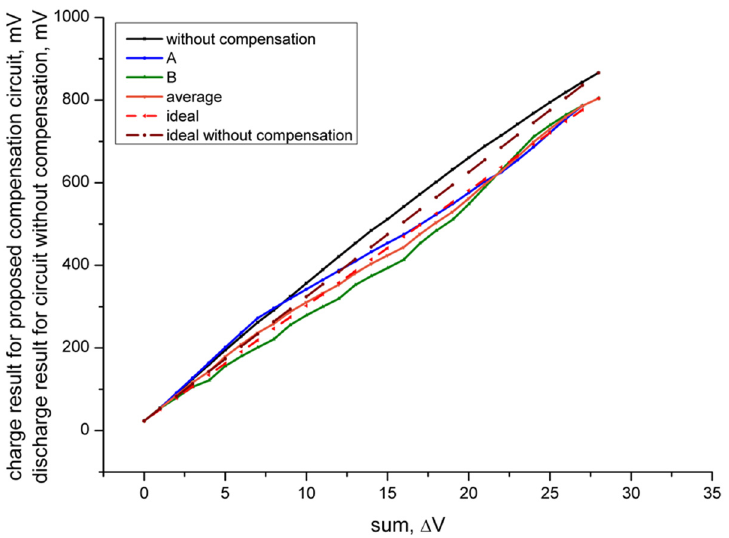
Figure 4. Accumulation results with/without compensation. A is the largest charge achievable through all combinations. B is the smallest charge achievable through all combinations.